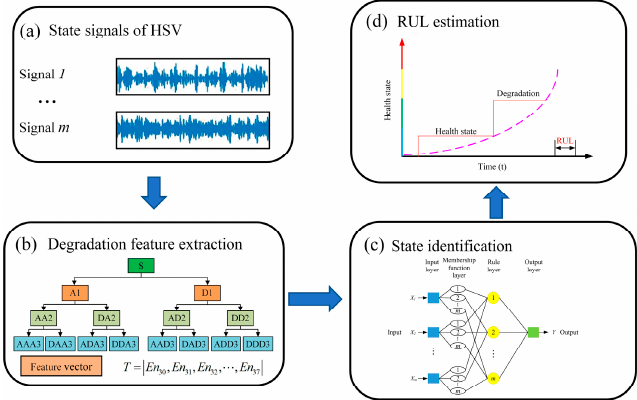
Figure 1. Scheme of the data-driven prognostic strategy.